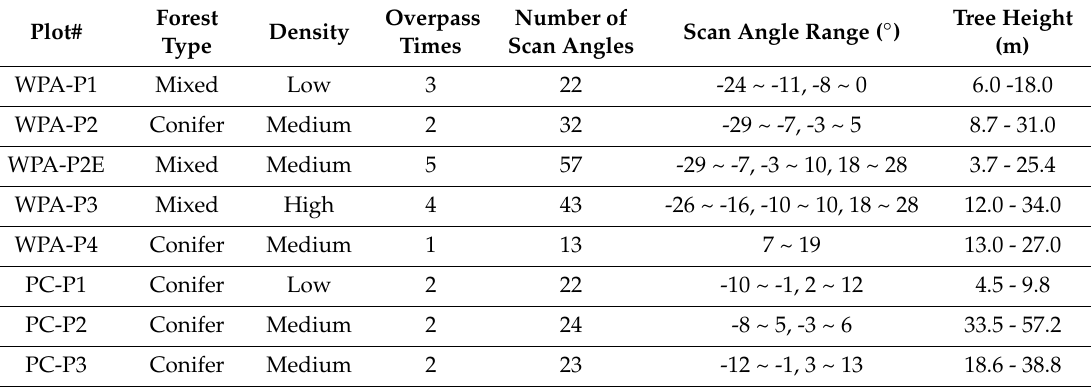
Table 1. Characteristics of seven forest plots for forest plots in both Washington Park Arboretum (WPA) and Panther Creek (PC)